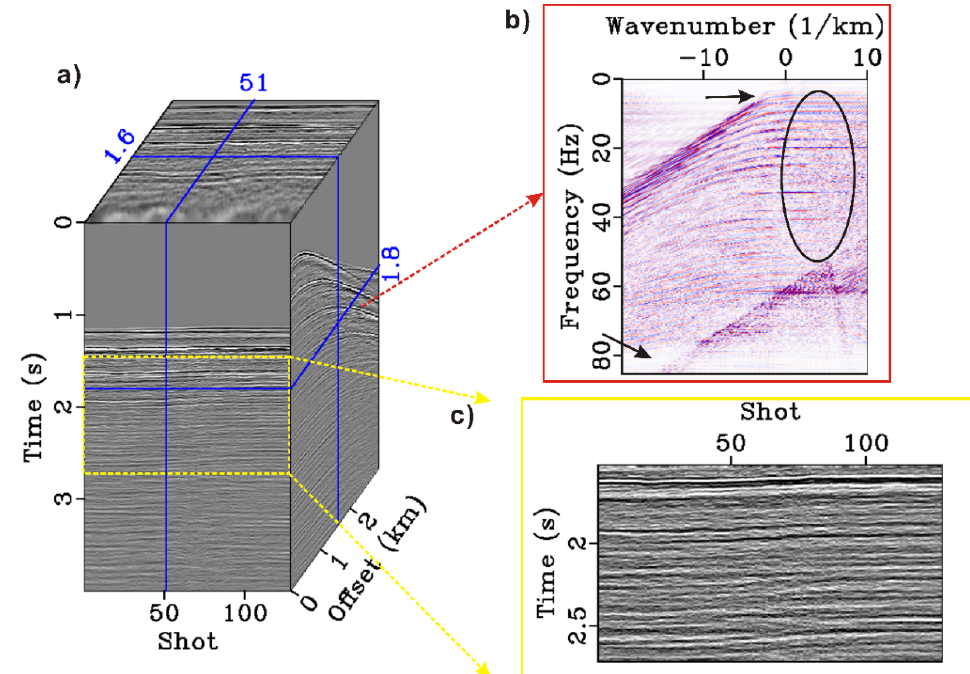
Figure 11. The 2D deghosting results. ( a ) 3D data cube including 193 CSGs and 128 COGs. ( b ) f - k spectrum in which the black oval marks the effect of ghost. ( c ) COG wherein the events are similar to the underground interface.